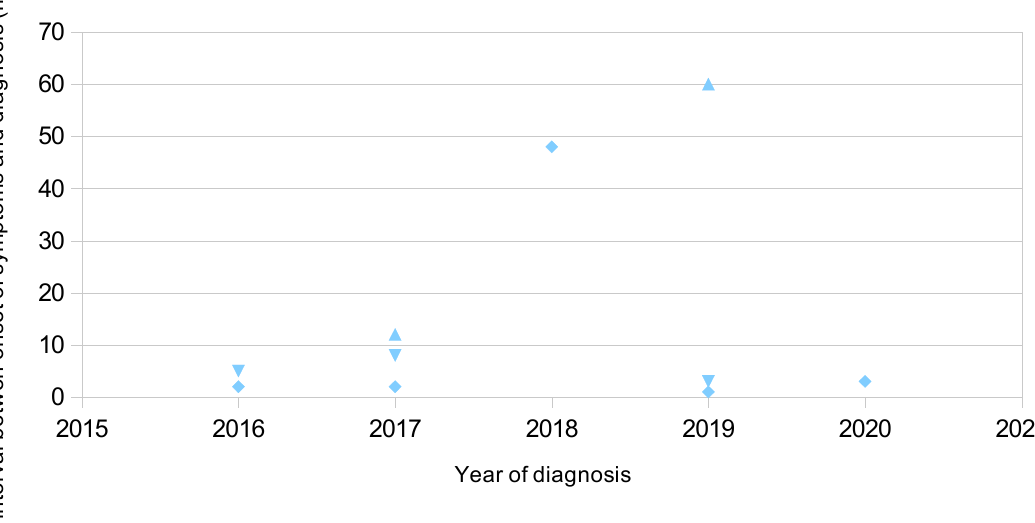
Figure 1. Time elapsed from the first clinical manifestation of chronic recurrent multifocal osteomyelitis to the final diagnosis. Table 2. Localization of bone lesions in the study patients.